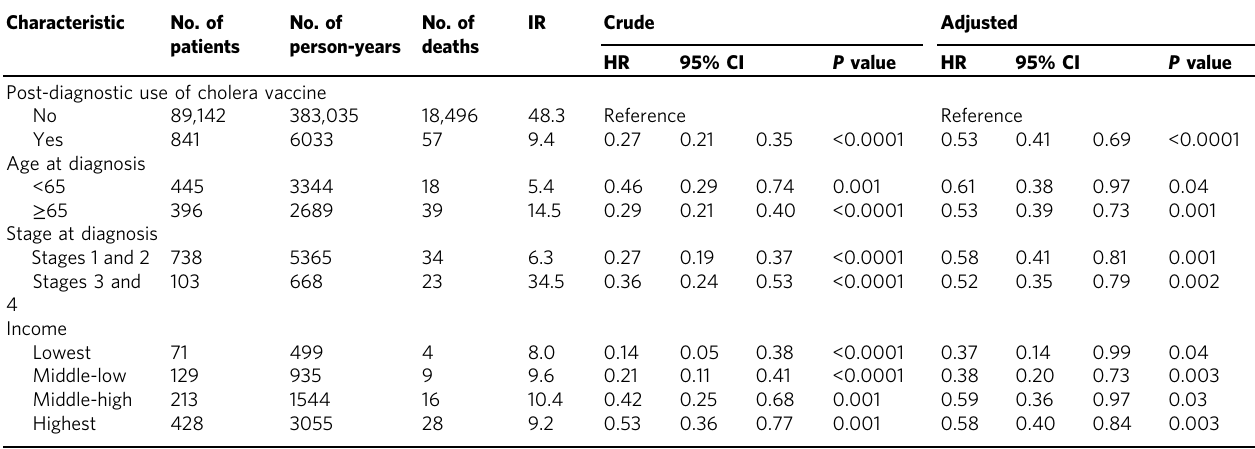
Table 3 Hazard ratios of overall mortality among patients with post-diagnostic use of cholera vaccine as compared to patients without cholera